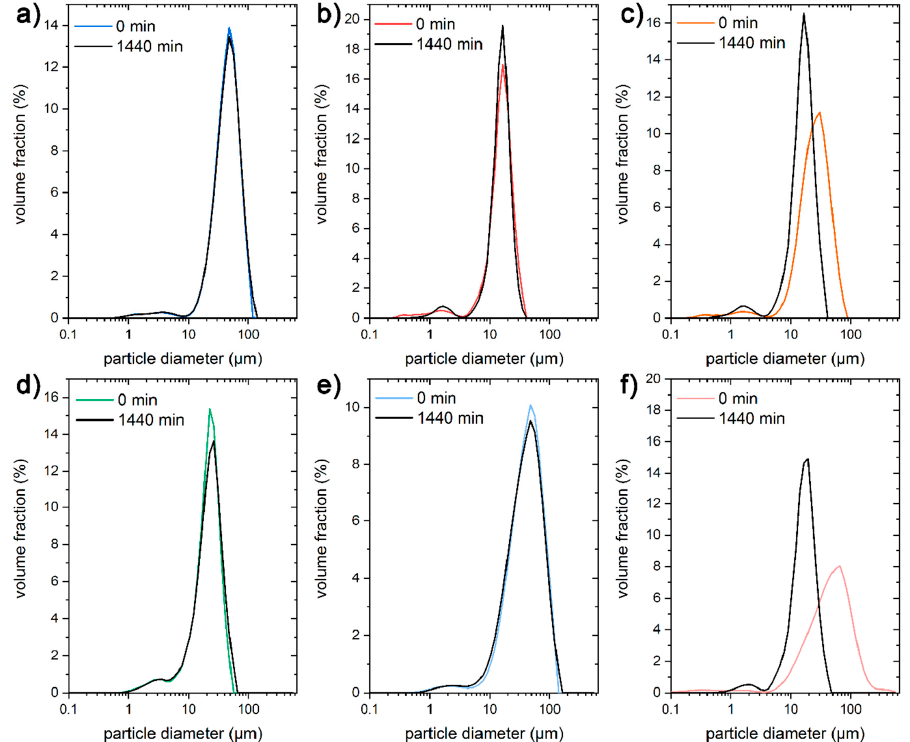
Figure 6. Particle size distributions in aqueous solution at 0 min and 24 h of ( a ) native potato starch, ( b ) native corn starch, ( c ) native waxy corn starch, ( d ) native wheat starch, ( e ) oxidized potato starch, and ( f ) oxidized corn starch.